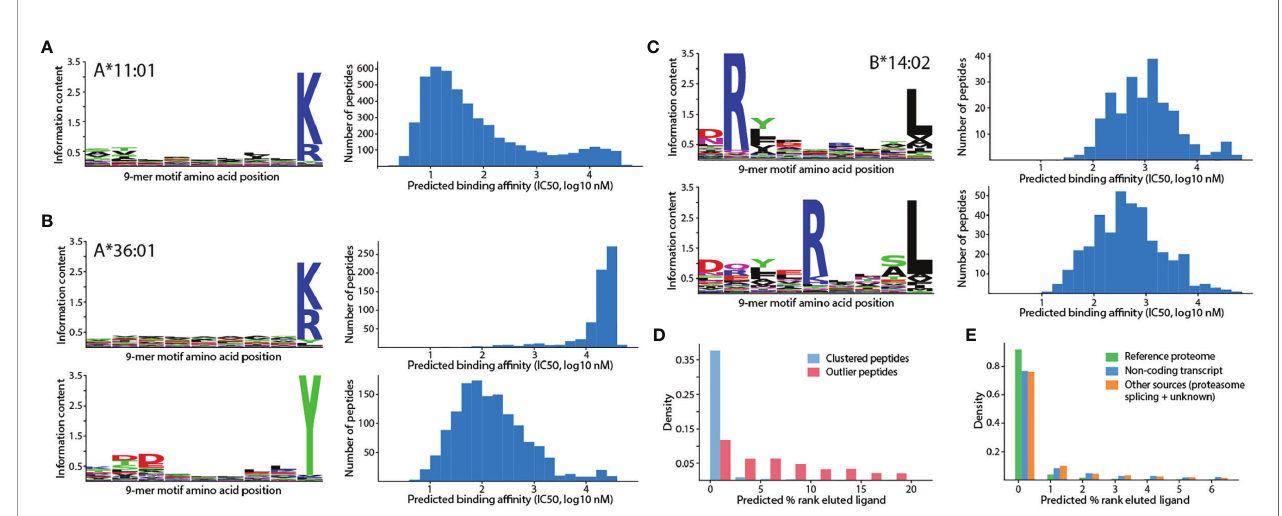
FIGURE 2 | Unsupervised clustering revealed potential false positives and multiple motif speci fi cities. (A) Single 9-mer motif identi fi ed for HLA-A*11:01 together with predicted binding af fi nities (IC50, nM unit). (B) Two motifs identi fi ed for HLA-A*36:01, one of which consists mainly of tryptic peptides and exhibits lower af fi nities (higher IC50 value indicates lower af fi nity). The top motif is expected to be a false positive. (C) Two distinct motifs identi fi ed for HLA-B*14:02 with arginine at different residue positions but similar predicted af fi nities. (D) Distributions of predicted percentage rank (% rank) of eluted ligand for clustered peptides and outlier peptides. A higher % rank indicates lower binding af fi nity. Bin size is 2%. (E) Distributions of predicted percentage rank of eluted ligand for peptides from various sources. Bin size is